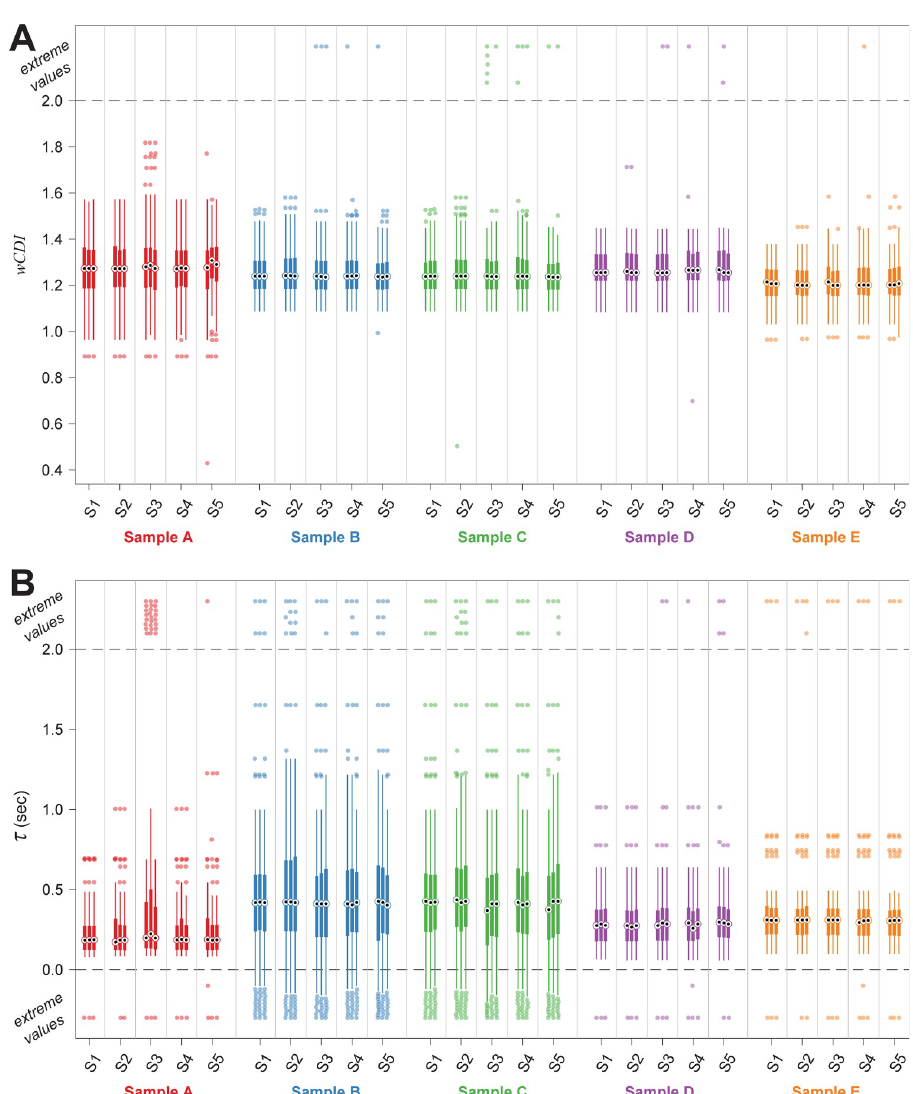
Fig 3. Intra- and inter-user comparison of results obtained using the mechano-NPS data processing pipeline. Processed data obtained from measurements of AP-1060 cells. Data sets A–C were obtained from measuring untreated cells, while data sets D–E were obtained from measuring cells treated with Latrunculin A (LatA). Plots show wCDI (A) and recovery time constant τ (B) results, respectively. Processed data is shown from each of the five subjects across three replicate data processing tasks. Data is presented as originally returned after the data processing task was completed (i.e., before erroneous measurements were excluded). Sample medians are represented by black dots; sample interquartile ranges are represented by thick lines; outliers are represented by filled circles and are defined as 1.5 times the inter-quartile range. Extreme values are represented as filled circles placed above or below the dashed lines and are defined as > 2 or < 0 for both wCDI and τ . Number of cells found in each observation ranged from